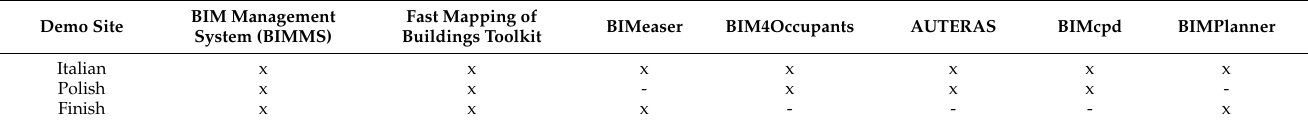
tion site as indicated in the Table 1. Table 1. Tools application on demonstration Table 1. Tools application on demonstration sites .